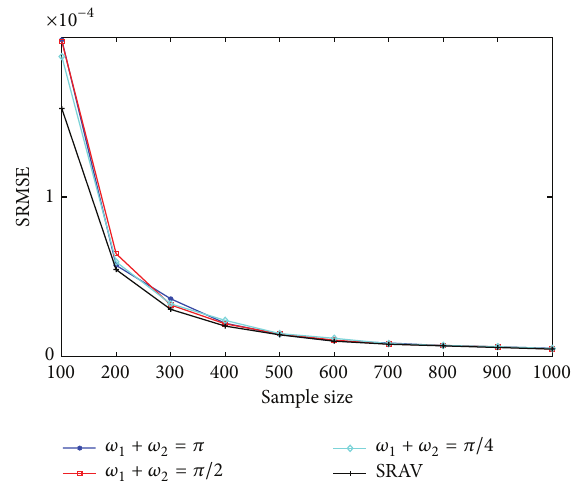
Figure 4: Plot of the SRMSEs for Model 1 to Model 3 as well as the SRAVs for different sample sizes when 𝜎 2 0 = 1.5